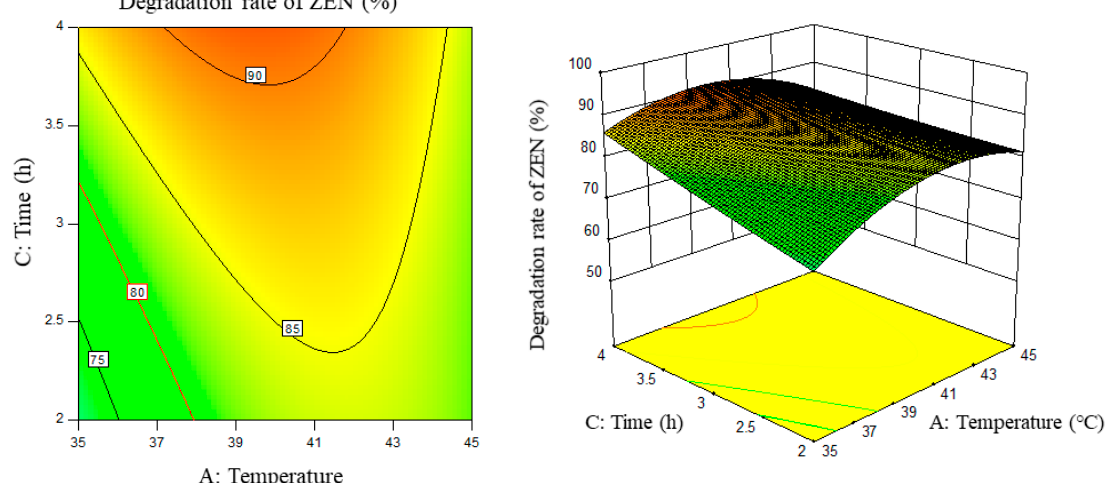
Figure 6. Temperature, time, and their interaction vs. the response surface and contour line of the degradation rate of ZEN.